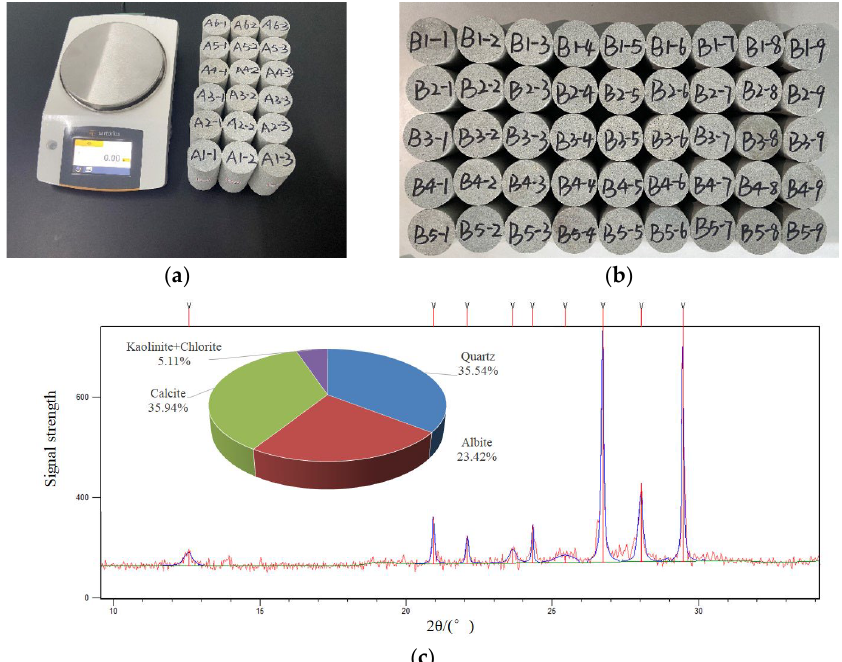
Figure 1. Experimental preparation. ( a ) Standard sample used in the uniaxial compression experi- ment; ( b ) Standard sample used in the triaxial compression experiment; ( c ) Mineral composition of sandstone samples used in the study.